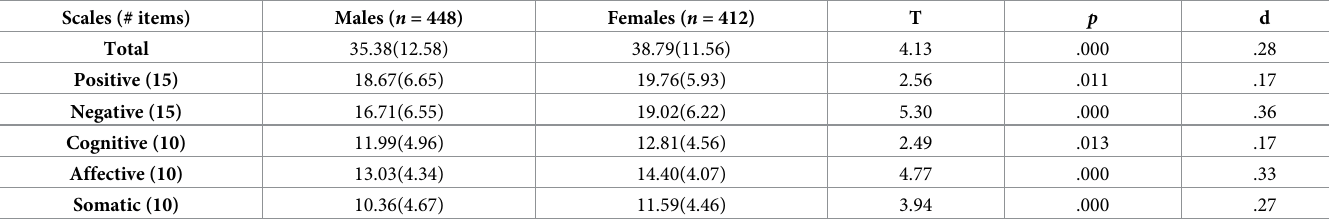
Table 4. Sex differences in CASES empathy scores with means, SDs, and effect sizes (Cohen’s d).